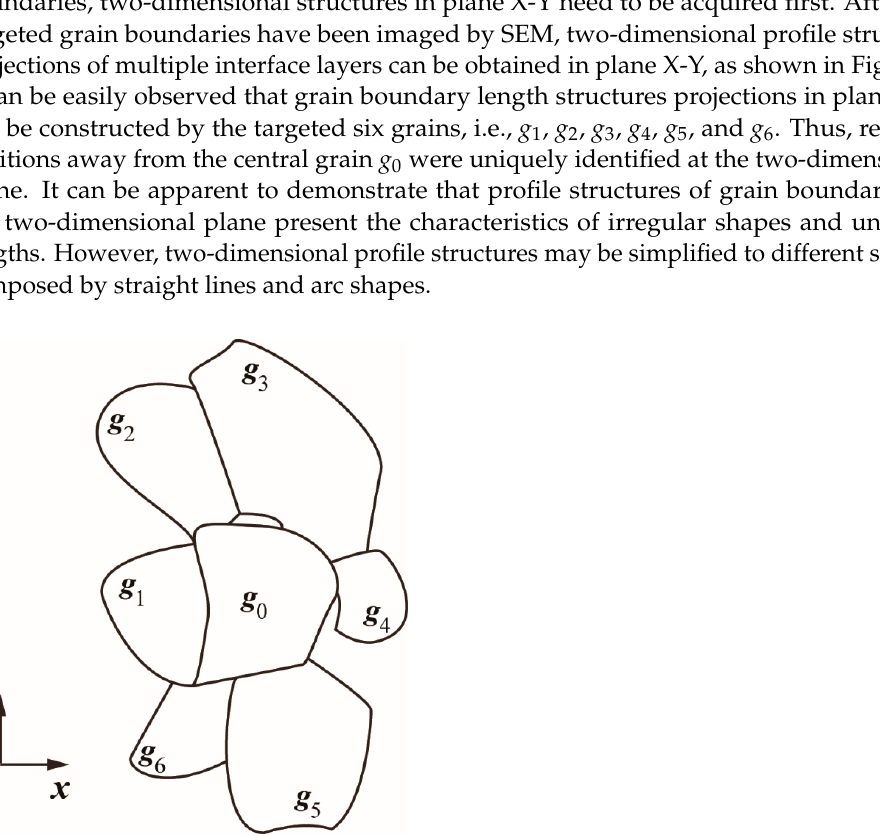
Figure 1. Schematic diagram accounting for three-dimensional characterization of nonlinear struc- ture lengths of micro-area grain boundary interfaces in bulk ZnO ceramics.